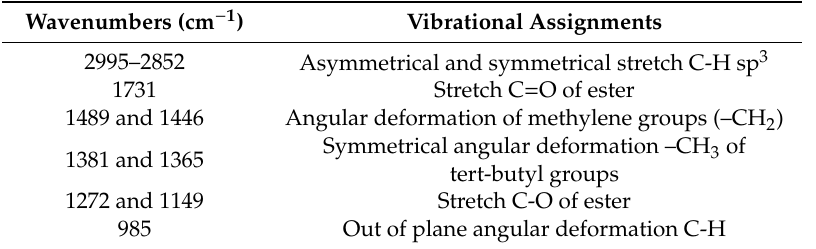
Table 1. Main absorption bands obtained in FTIR spectra for PMMA / OM-OA and PMMA / OM-OA / PVPi samples and their vibrational assignments.